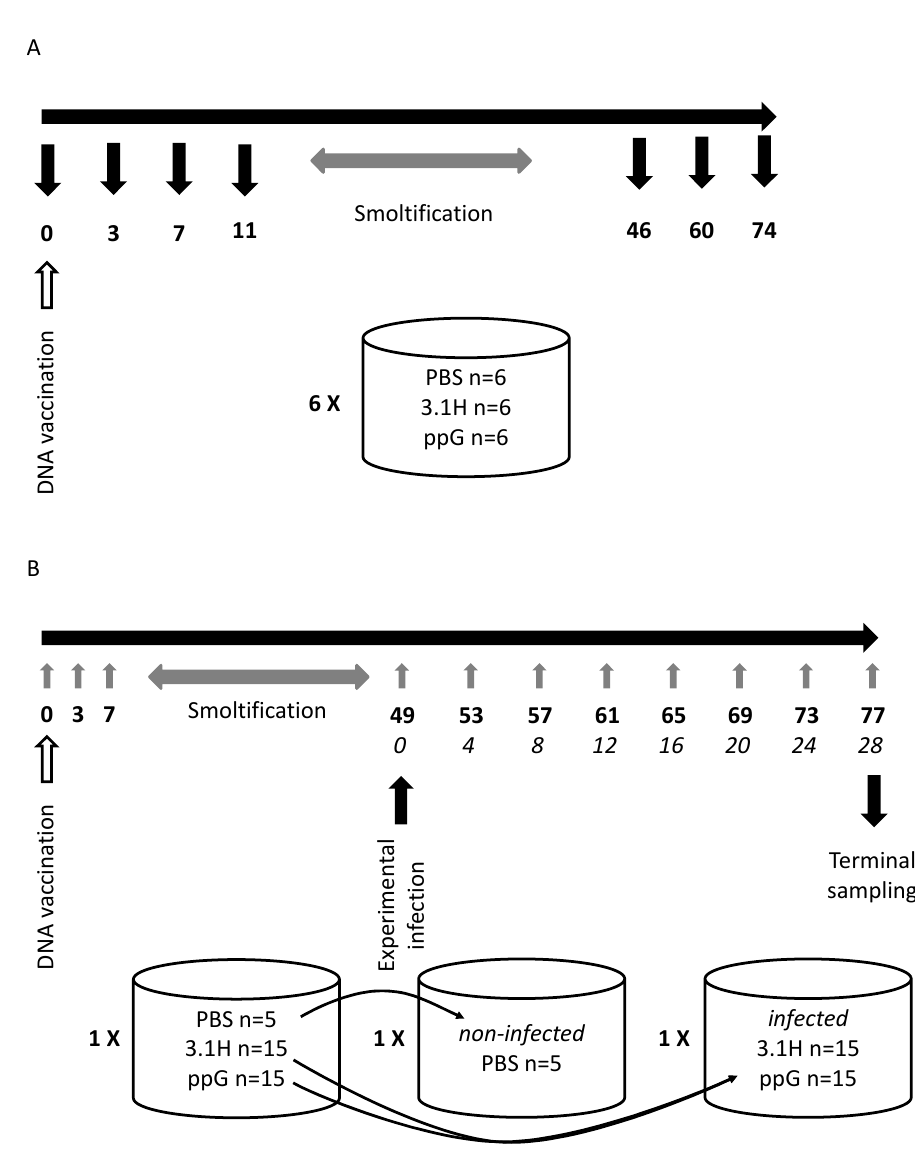
Figure 1. Overview of experimental design for Salmon Pancreatic Disease virus (SPDv) DNA vaccination of salmon. ( A ). Experiment 1 (lethal sampling, vaccination only, no viral challenge). ( B ) . Experiment 2 (non-lethal sampling, vaccination followed by immersion challenge). Numbers in bold correspond to days post-vaccination, numbers in italic correspond to days post infection, grey upward arrows correspond to non-lethal blood collections, and black downward arrows corre- spond to lethal tissue sampling. ppG is the DNA vaccine (pcDNA3.1-Hyg-mEGFP-pp4640 plasmid containing SPDv struc- tural polyprotein), and 3.1H is the empty vector control